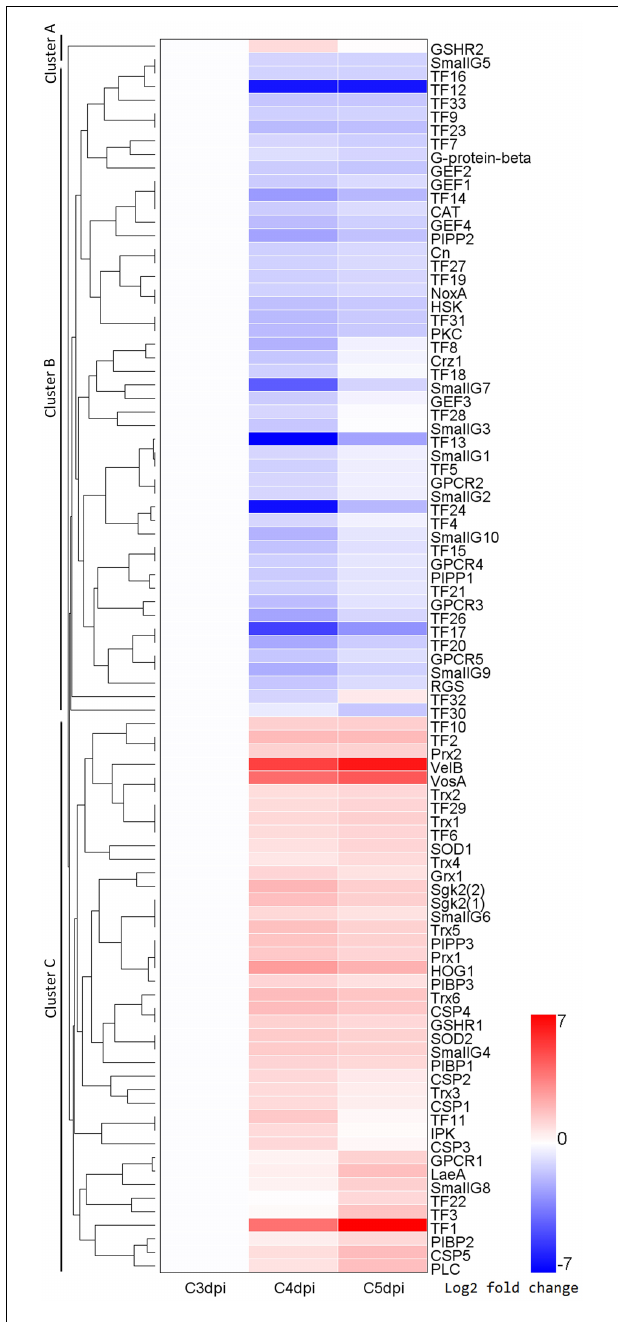
FIGURE 6 | A heatmap for the expression patterns of 91 putative regulator coding genes in Bgt at 3, 4, and 5 dpi. Regulatory pathways in which these regulators participated in include the G protein signaling, small G protein signaling, calcium signaling, H 2 O 2 signaling, PIP signaling and transcriptional regulation. A hierarchical clustering analysis revealed three major clusters, Cluster A, Cluster B, and Cluster C. The detail information of these genes is listed in Supplementary Table S7. G-protein-beta, heterotrimeric G protein beta subunit; RGS, regulator of G protein signaling; GPCR, G protein coupled receptor; SmallG, small G protein; GEF, guanine nucleotide exchange factor; SOD, superoxide dismutase; CAT, catalase; Prx, peroxiredoxin;